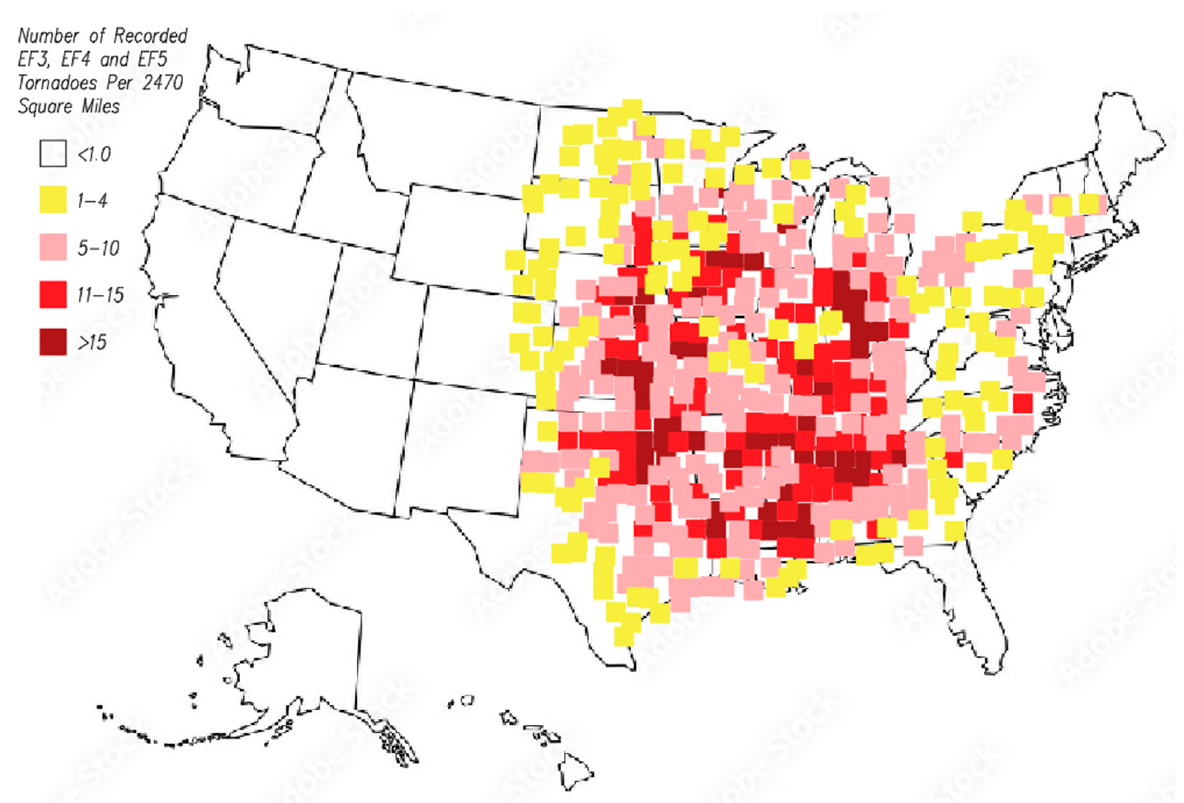
Figure 4. Tornado activity in the USA. Number of recorded EF3, EF4 and EF5 tornadoes per 2470 square miles. [23].